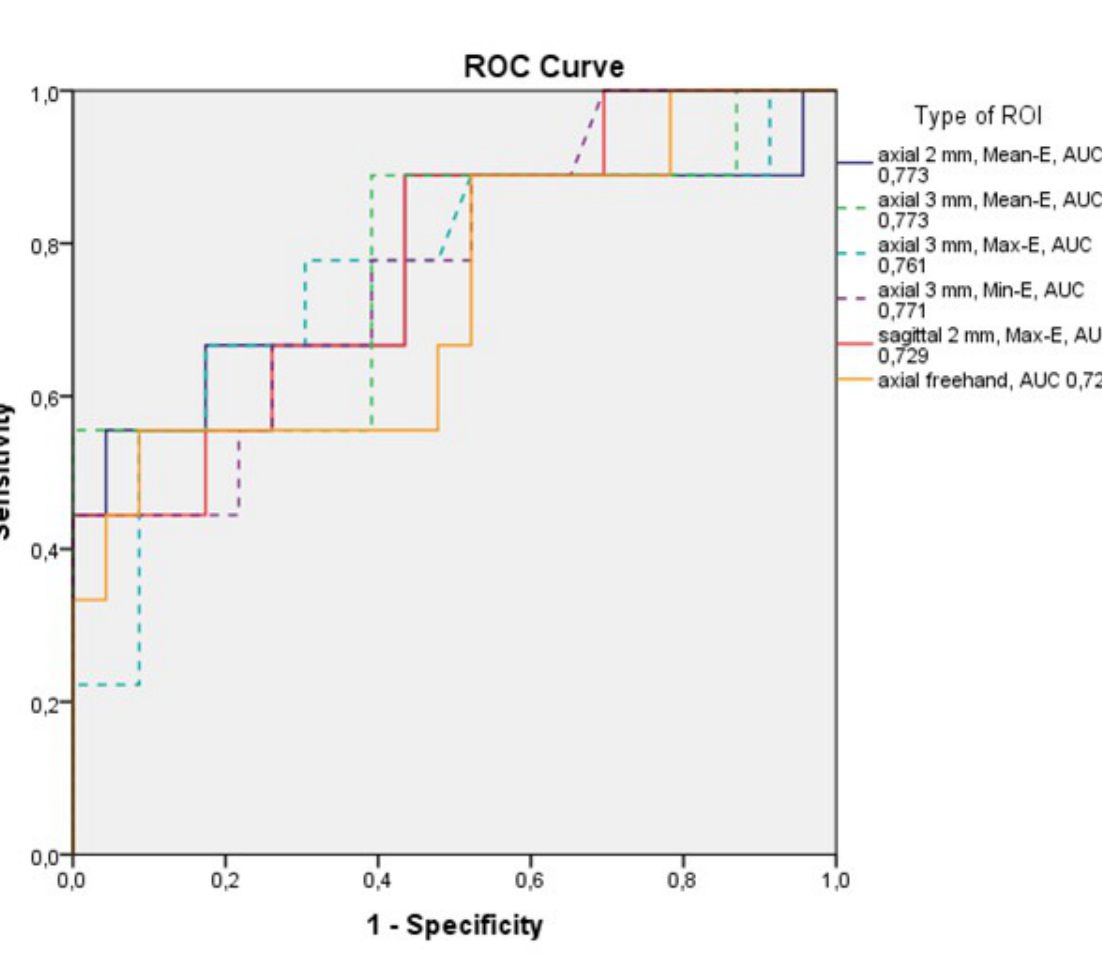
Fig 4. Receiver operating characteristic (ROC) curves of SWE ROIs with the highest AUC values. Axially placed 2 mm and 3 mm ROIs yielded the best results with Mean-E (88.9% sensitivity, 56.5% specificity and 88.9%, 60.9% respectively) and 3 mm Max-E (77.8% sensitivity and 69.4%